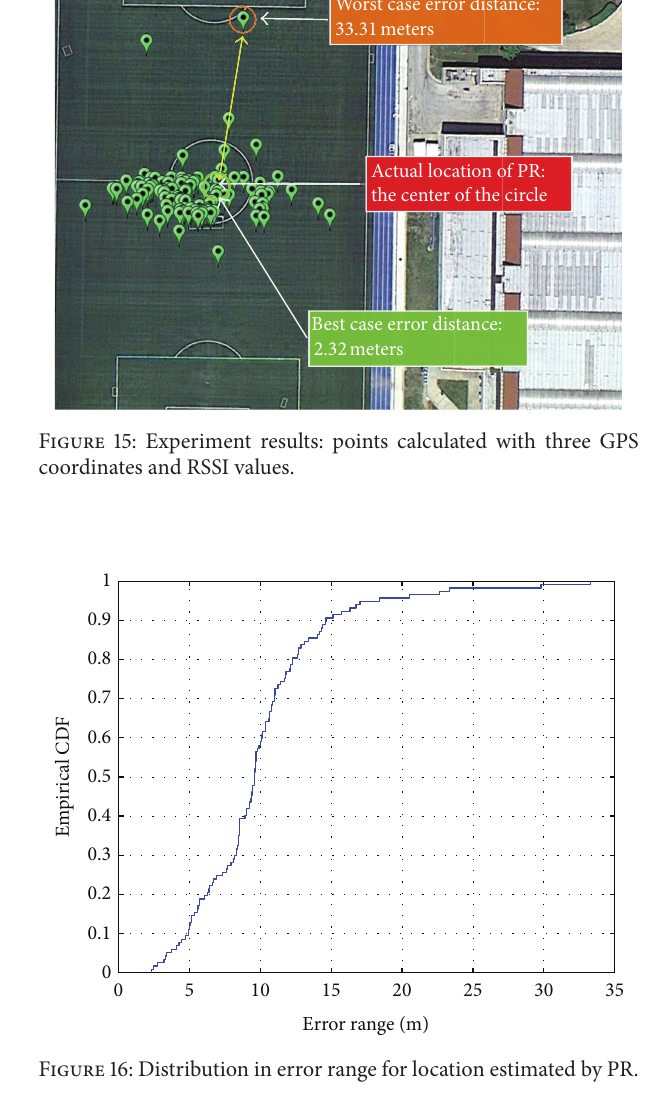
Figure 14: An example of field experiments.